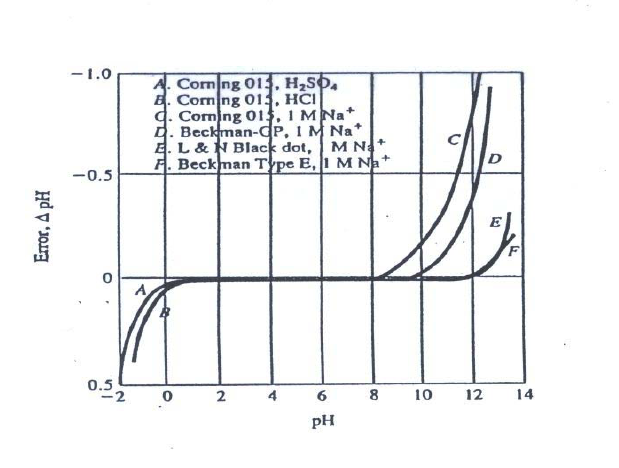
Figure 1. Acid and alkaline error for selected glass electrodes at 25 C. (from R. G.